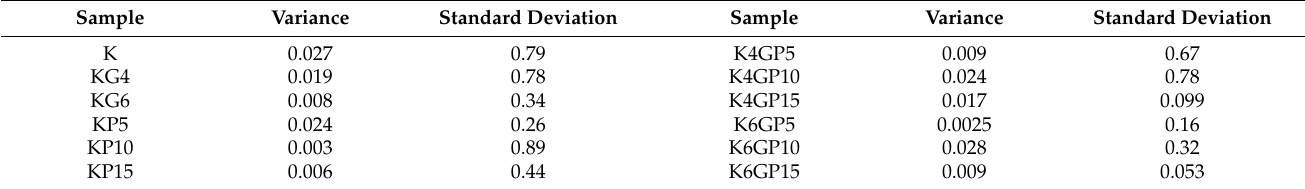
Figure 12. Stress–strain curve of kaolin and stabilized kaolin with gypsum and POFA tested after 28 days of curing.